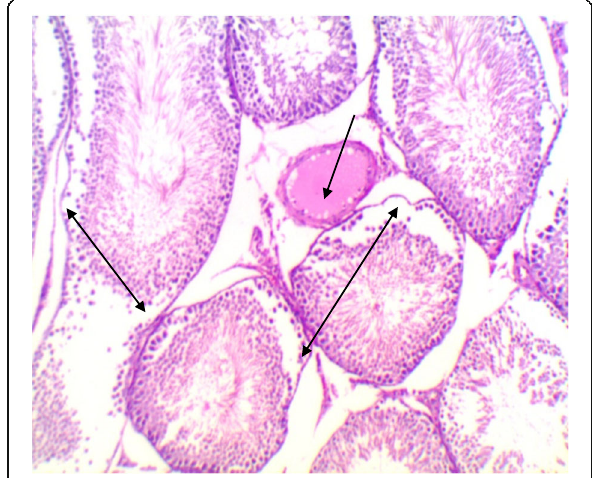
Fig. 20 Photomicrograph of control testis showing normal architecture (H&E;400)